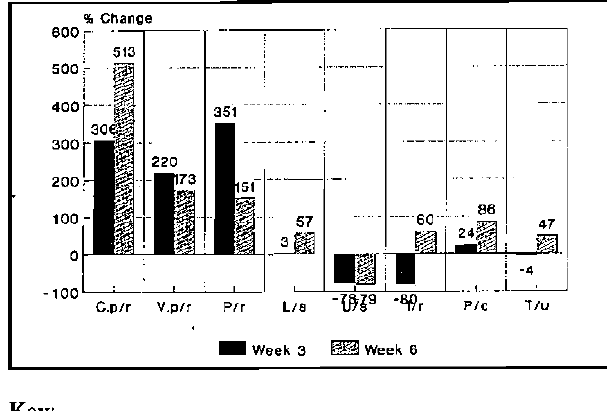
C.p/r = Concrete positive reinforcement; V.p/r = Verbal